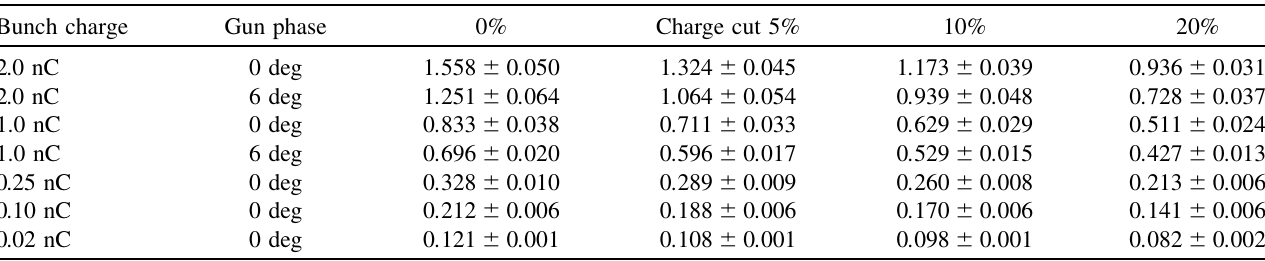
TABLE IV. Core xy emittance (mm mrad) measured for various bunch charges and gun phases. Only statistical errors are shown (see